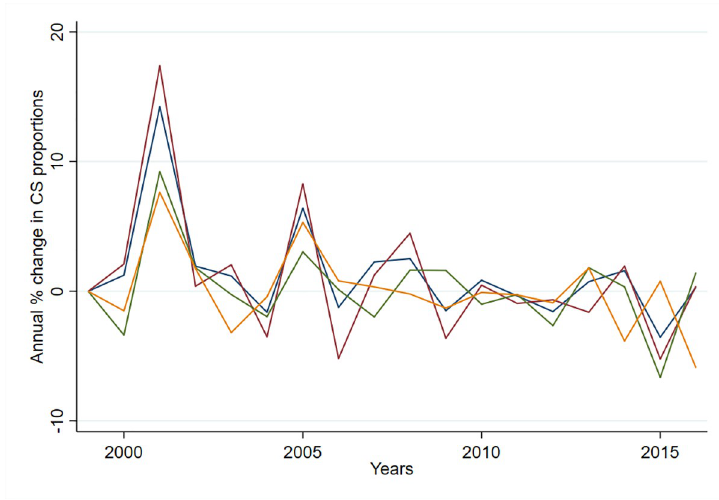
Fig 5. Year-to-year percent change in proportions of observed CS births overall and in stratified groups. All CS births (blue). CS births with none of the selected risk factors (red). CS births with 1 risk factor (green). CS births with > 1 risk factor (yellow). CS, cesarean section.